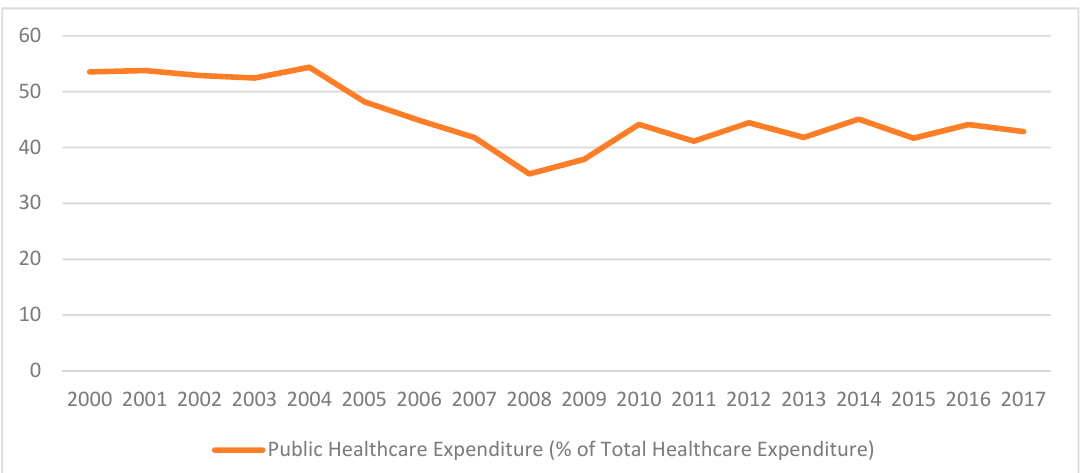
Figure 2. Evolution of Public Healthcare Expenditure as a Percentage of Total Healthcare Expenditure. Source: Authors’ own computation.